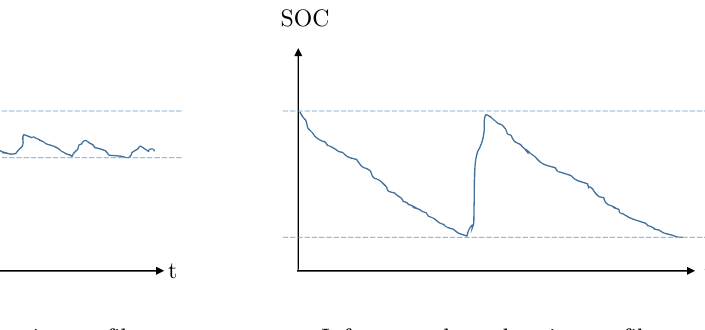
Figure 7. Dynamic wireless